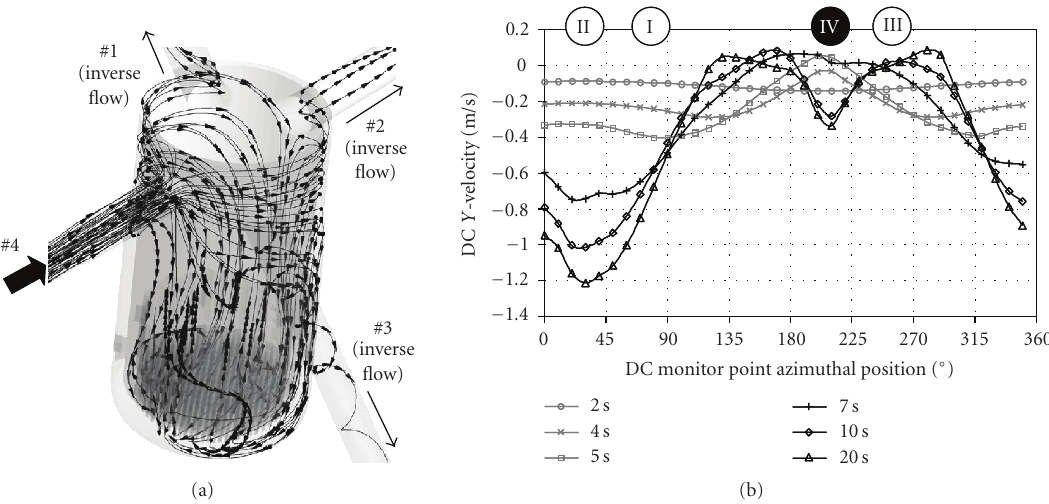
Figure 6: Numerical results: (a) velocity field (streamlines from loop 4); (b) azimuthal velocity profile in